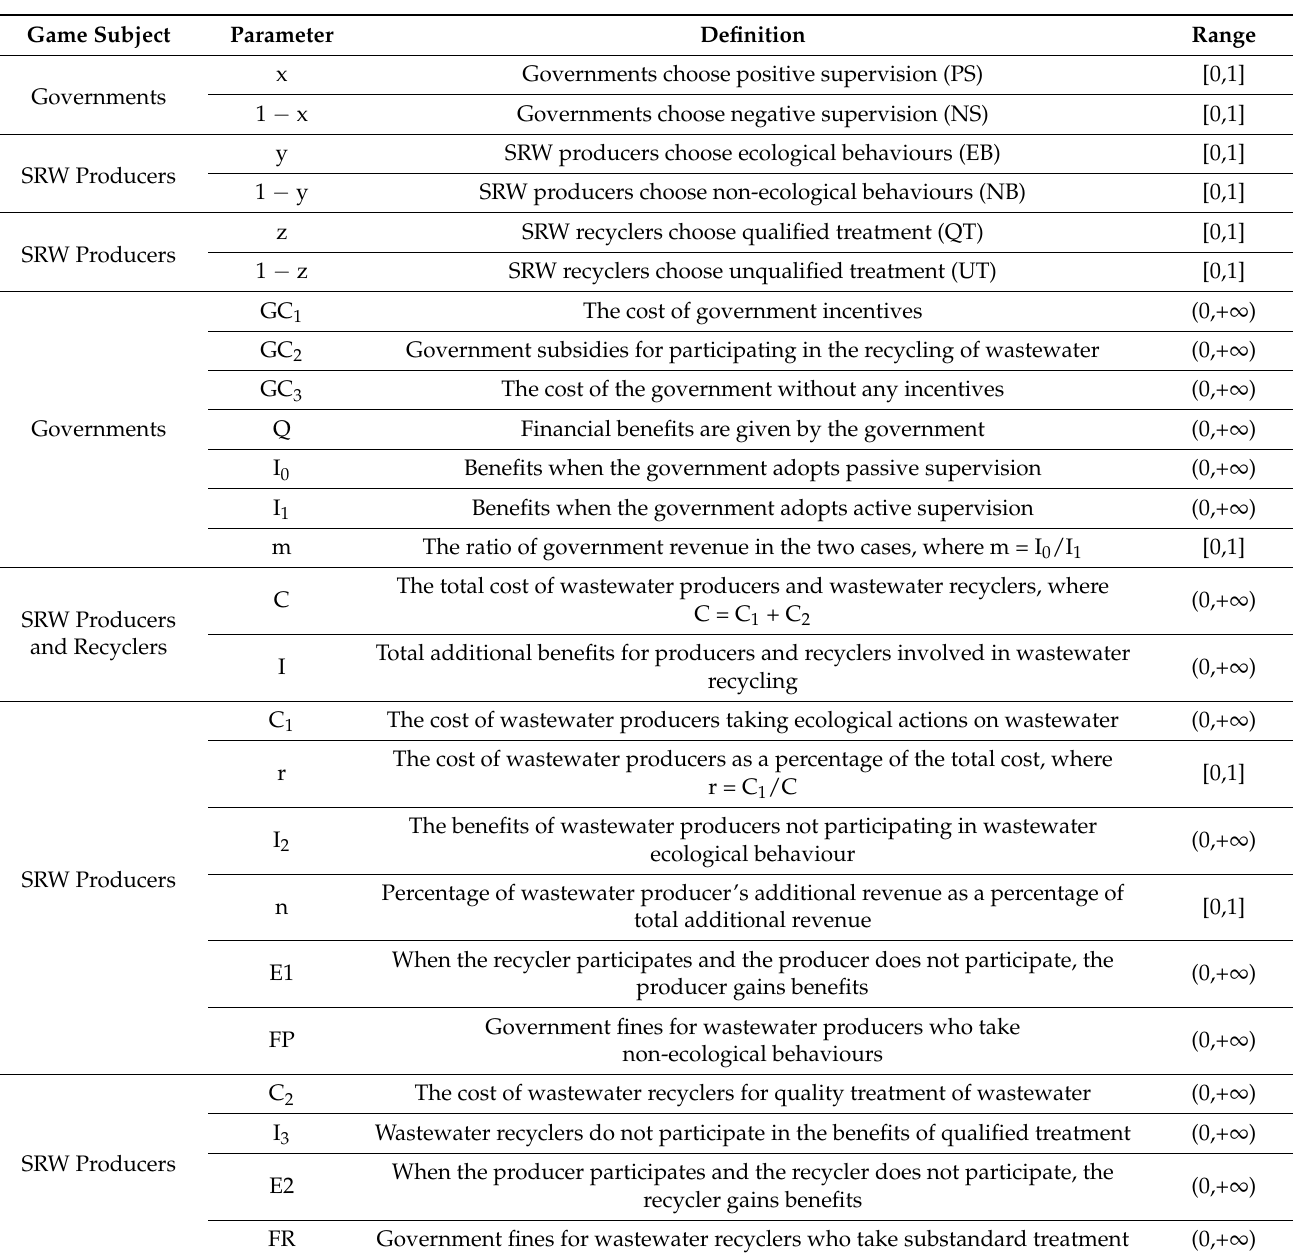
Table 1. Definition of